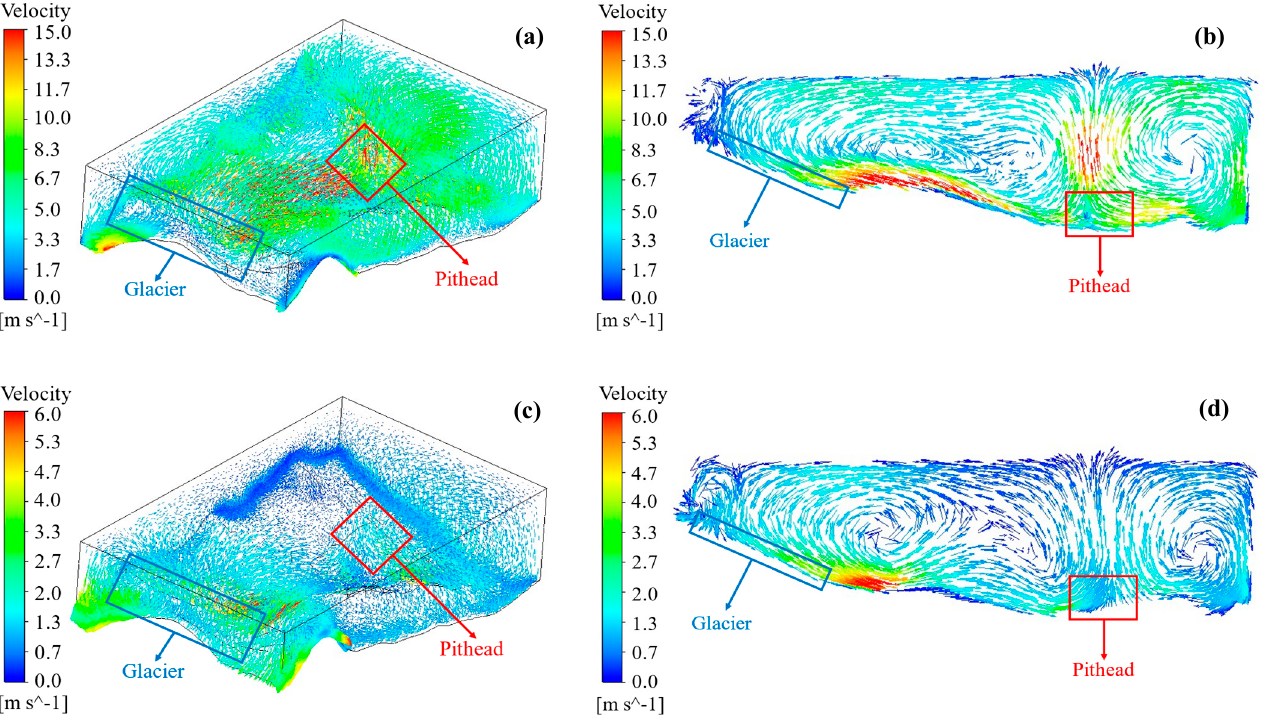
Figure 7. Airflow field in the alpine mining area (study area). ( a ) Three − dimensional (3D) view of the wind speed in winter. ( b ) Profiles of winter wind speed and direction. ( c ) Three − dimensional (3D) view of the wind speed in summer. ( d ) Profiles of summer wind speed and direction.